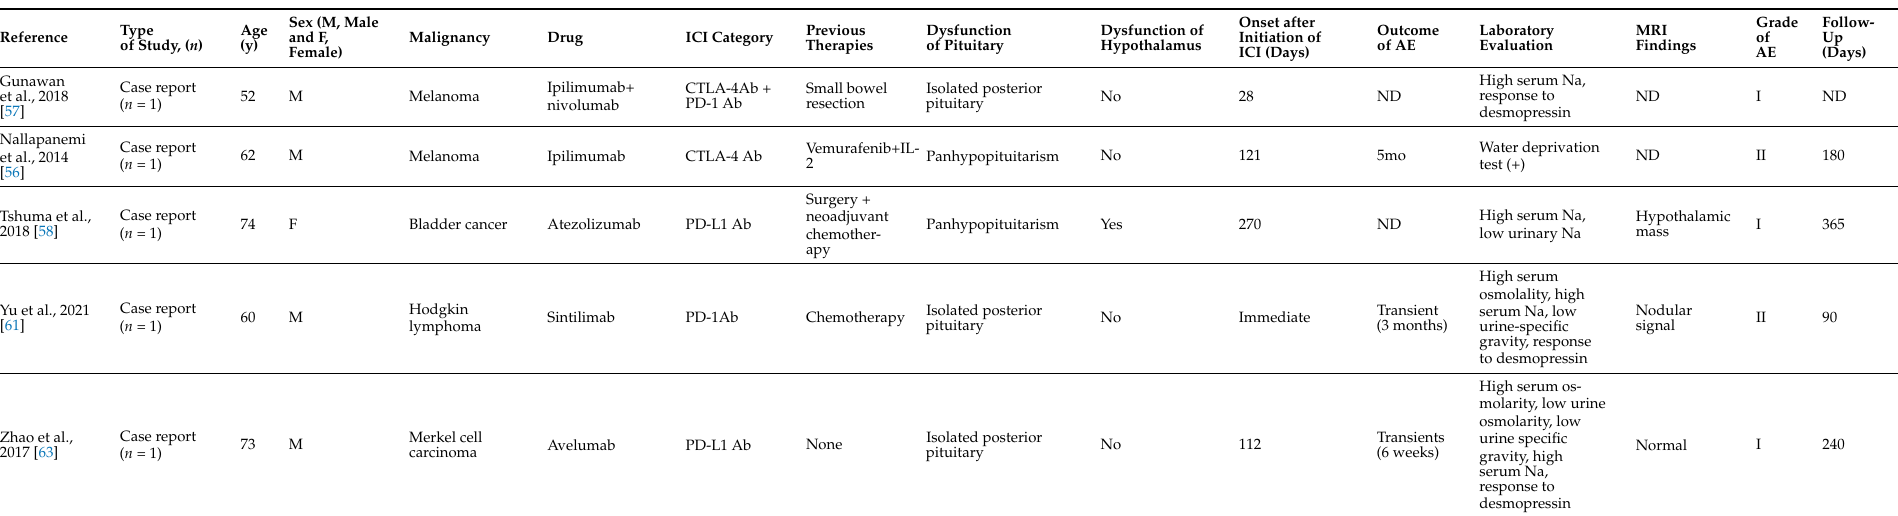
treatment with desmopressin. b The patient deceased 50 days after desmopressin